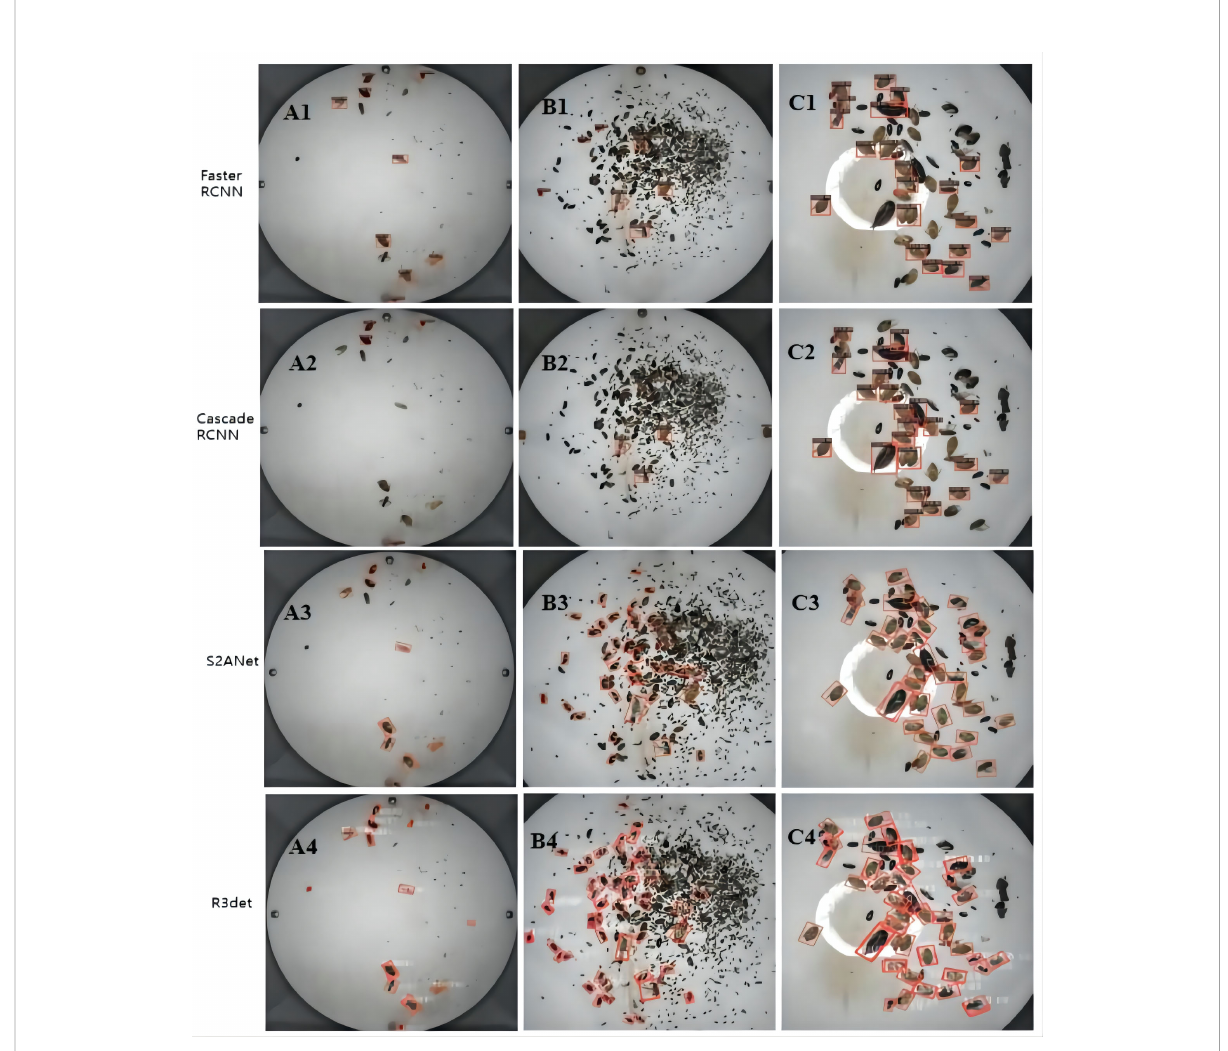
FIGURE 8 Comparison between horizontal algorithm and rotation algorithm. The algorithm model for comparison is Faster RCNN, Cascade RCNN, S2ANet and R3Det. Test fi gure (A) represents small-target pest detection, (B) represents intensive pest target detection, and (C) represents interpest occlusion type